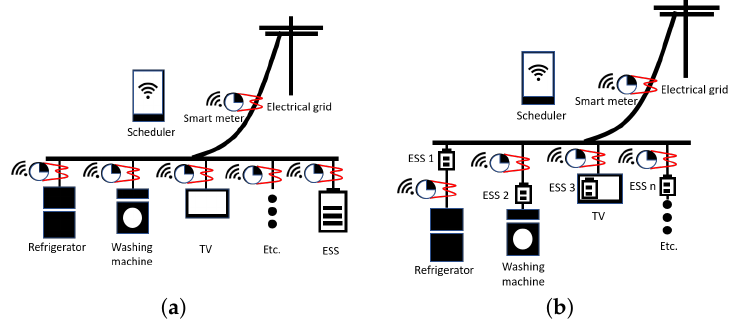
Figure 2. Smart home with battery ESS. ( a ) Central ESS. ( b ) Distributed